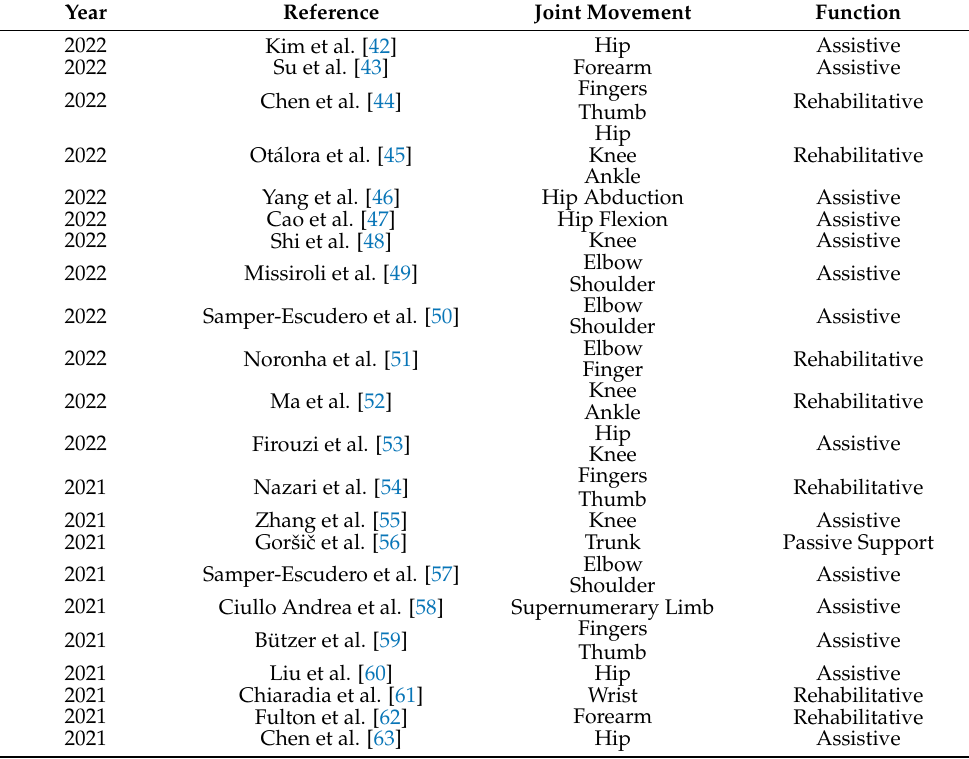
Table 1. List of publications that describe cable-driven soft wearables.